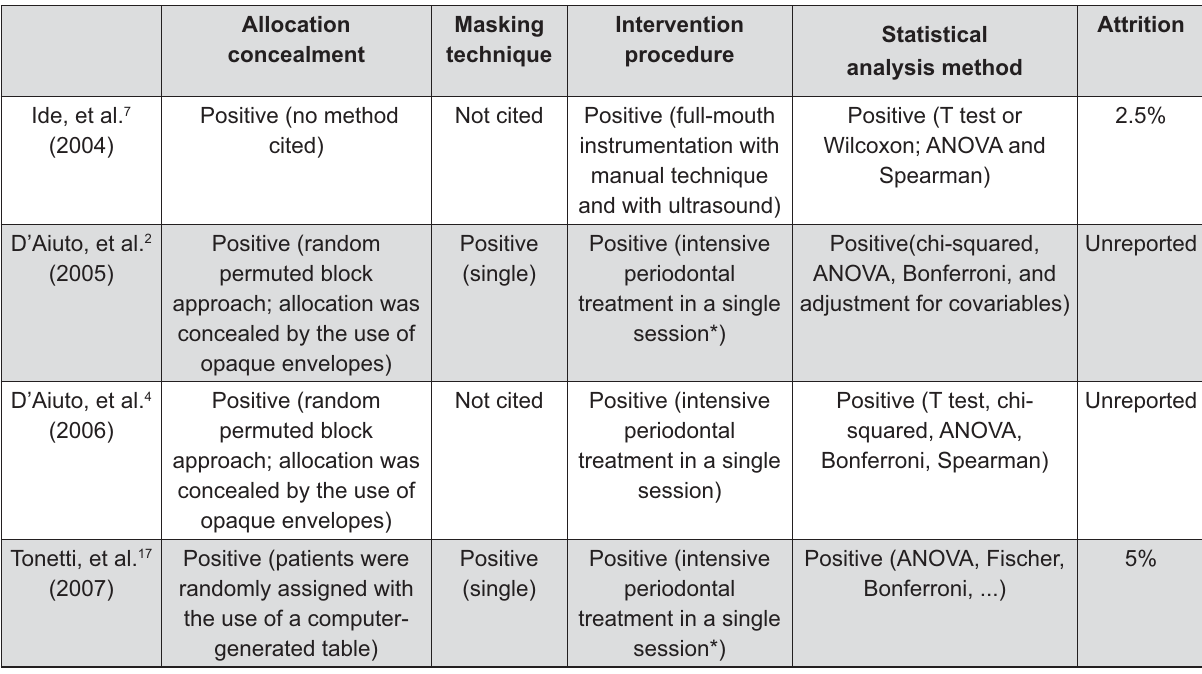
Figure 5- Qualitative evaluation of the randomized clinical trials included in the